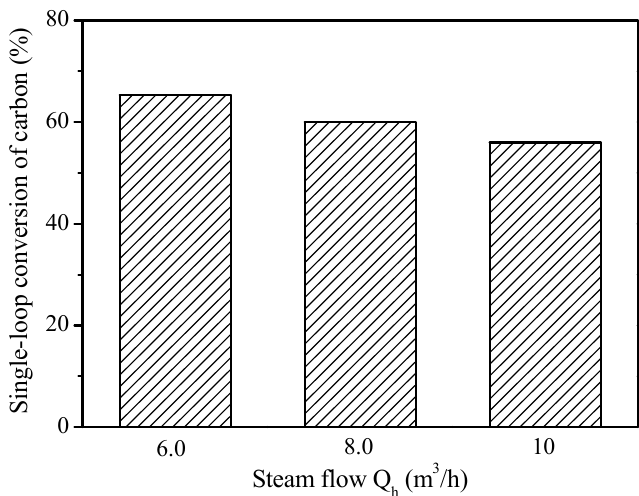
Figure 12. Effect of steam flow on the single-loop conversion of carbon in the fuel reactor.